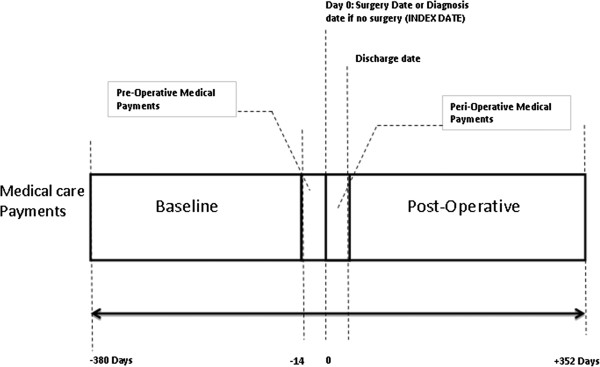
Study period for women with surgery/procedure for UF treatments. This figure delineates the various study periods, including the baseline and the follow-up operative period.